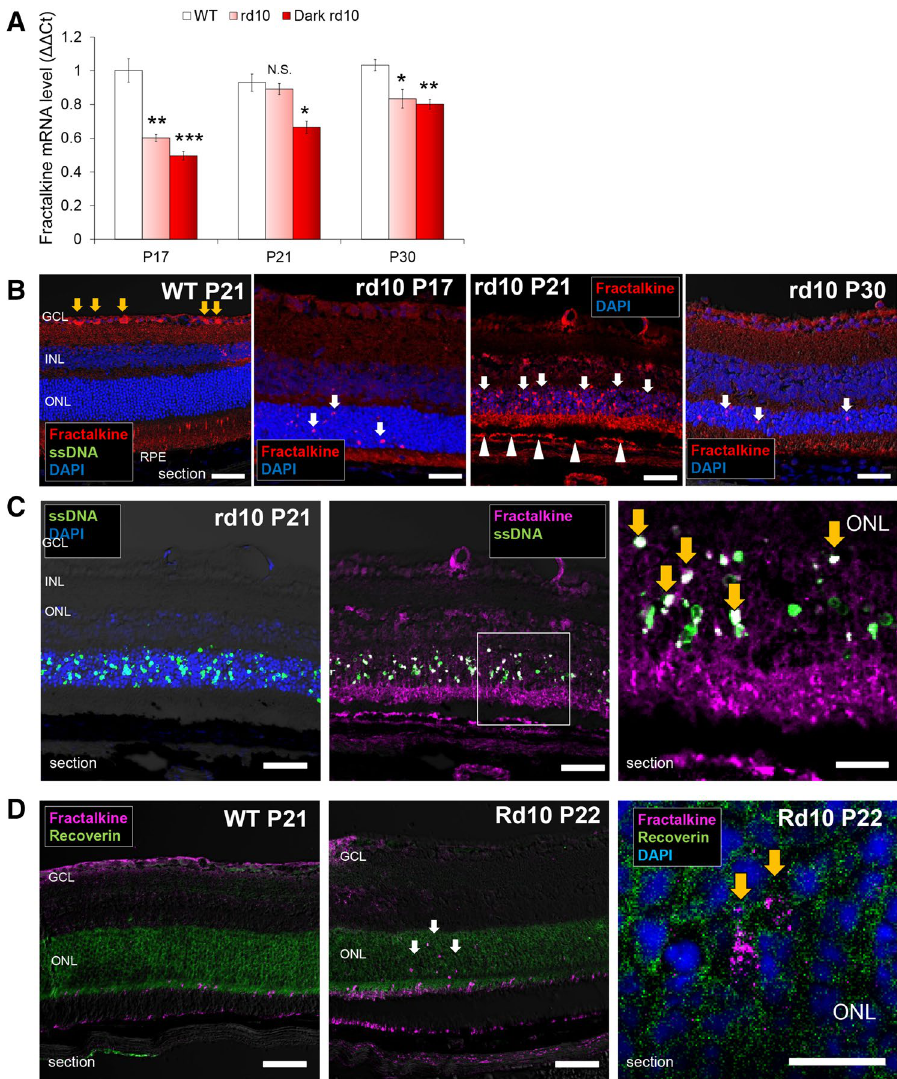
Figure 8. Expressions and localizations of fractalkine in the retina of rd10 mice. ( A ) Comparison of the mRNA expressions of fractalkine in the retinas of WT C57BL/6 J, rd10 raised under regular light cycle and rd10 raised in dark, by qRT-PCR. Results indicate the relative expression (ΔΔCR: WT P17 = 1). The graphs show mean and SD of three experiments (* p < 0.05, ** p < 0.005, *** p < 0.0005, **** p < 0.00005 compared to WT). N.S., not significant. ( B ) Retinas of WT (P21) and rd10 (P17 to P30) labeled with fractalkine. In WT retina, fractalkine + cells were found only in the GCL (yellow arrows). In the retina of rd10 , obvious fractalkine + cells were not found in the GCL but in the ONL (white arrows). On P21, fractalkine was also positive in the RPE (white arrowheads). Scale bars, 50 μm. ( C ) Retina of rd10 at P21 labeled with ssDNA and DAPI (left), and with fractalkine and ssDNA (middle). Magnified image of the ONL in the middle picture (right). SsDNA + cells scattered within the ONL and the localization of some ssDNA + cells coincided with the staining of fractalkine (yellow arrows). Scale bars, (left and middle) 50 μm, (right) 20 μm. ( D ) Retinas of WT (P21) and rd10 (P22) labeled with fractalkine and a photoreceptor marker recoverin. In WT retina (left) fractalkine + cells did not coincide with recoverin-positive photoreceptors. In the retina of rd10 (middle), fractalkine + cells coincided with recoverin-positive photoreceptors (white arrows). In the magnified image of the ONL in rd10 (right), granular staining of fractalkine was observed (yellow arrows). Scale bars, (left and middle) 50 μm, (right) 10